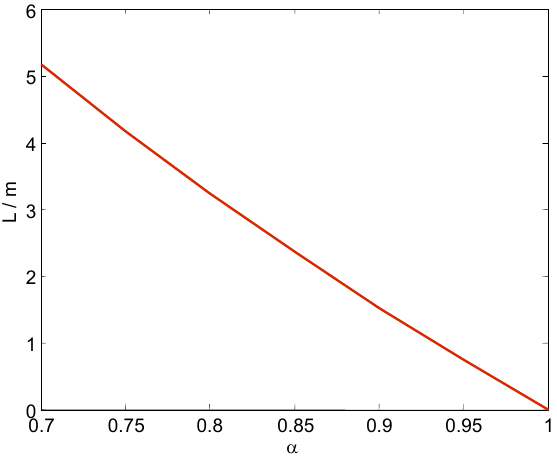
Figure 2. Relationship between fiber length and transmission